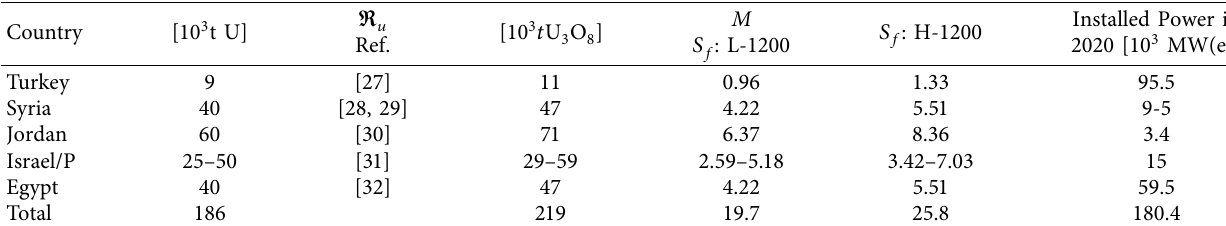
Table 6: Estimated potential for uranium self sufficiency in some countries of the EMC.